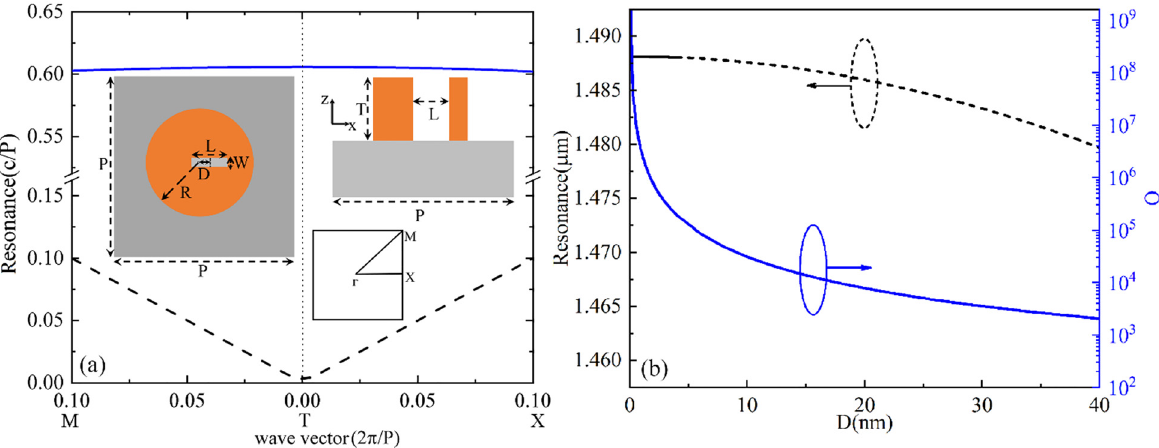
Figure 2: (a) band structure of the bound state in the continuum (BIC) mode supported by the slotted AlGaAs disk array. The blue line corresponds to the BIC mode and dashed line represents the light line. Inset: top (left) and cross-sectional (right) views of the single unit, wheretheairslotwithlength L andwidth W isetchedthroughtheAlGaAsdisk.(b)Calculatedeigenresonanceoftheassociatedqualityfactors supported by the slotted AlGaAs disk array, as a function of the relative position between the centers of the slot and the